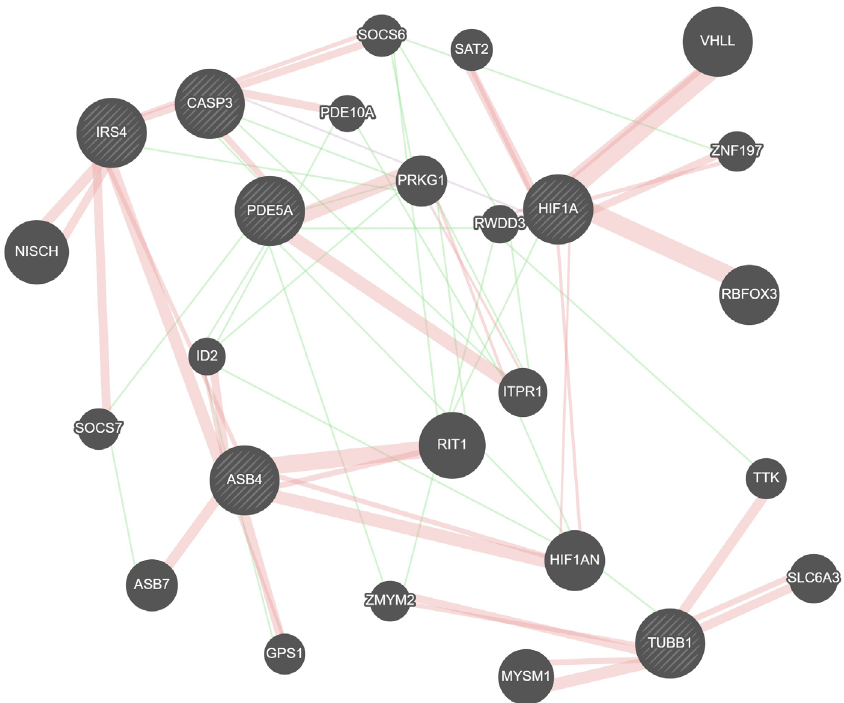
Figure 2. Gene interactions for Class I identifiers. Red represents physical interactions, purple represents co-expression, and green represents genetic interactions. Created using GeneMania